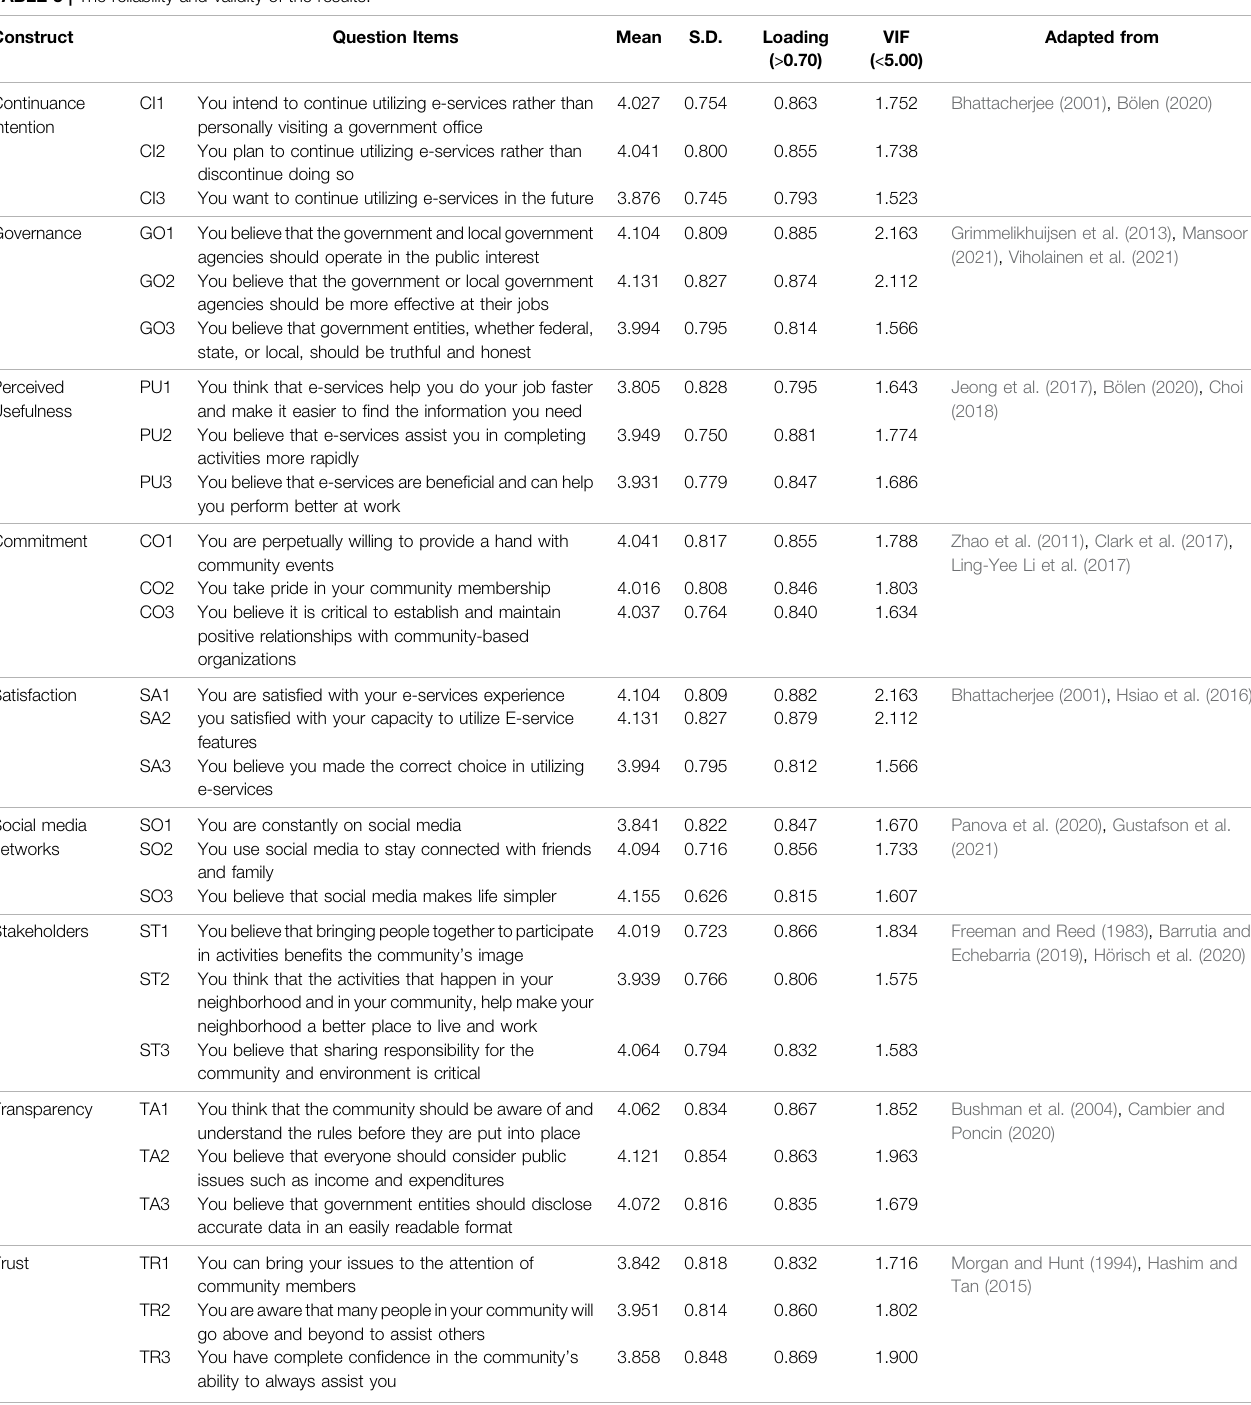
TABLE 3 | The reliability and validity of the results. Construct Question